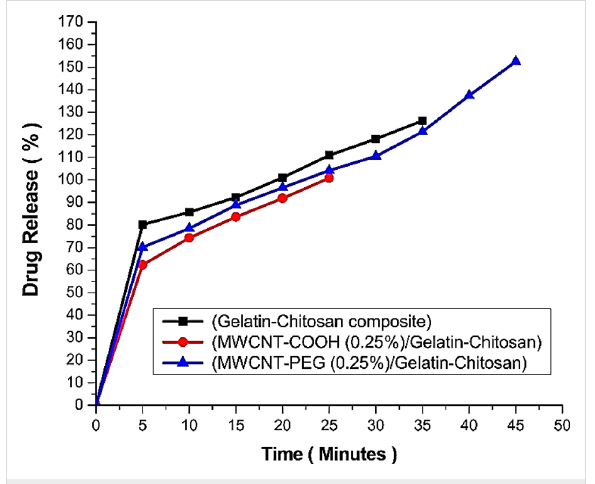
Figure 4: The ciprofloxacin release rate (%) from several composite films at pH 7.4. Figure 4 was reproduced from [68], (© 2018